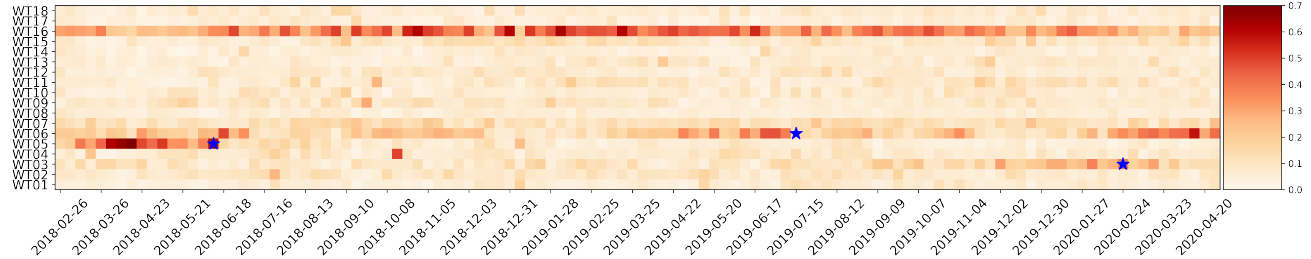
Figure 4. Main bearing health according to anomaly detection. Faults are marked with a blue